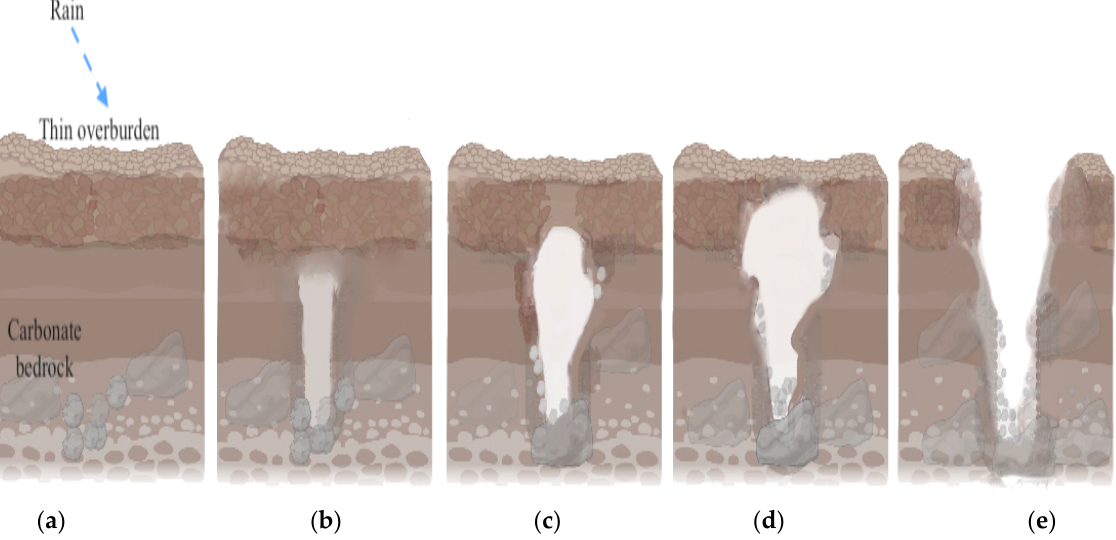
Figure A1. The gradual formation of a sinkhole from rainwater: ( a ) water gathers in thin overburden; ( b – d ) the water percolates through the soil, causing erosion and dissolution of carbonate bedrocks overtime; and ( e ) surface collapse forming sinkhole [17].